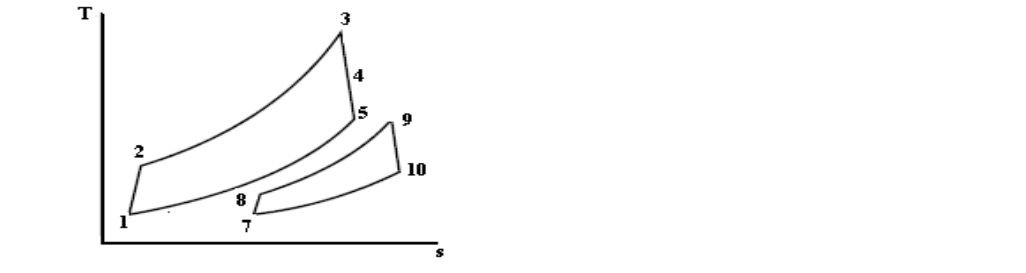
Figure 3. (T-s) diagram of the dual gas turbine combined cycle (1, 2, 3, 4, 5, 7, 8, 9 and 10 are the inlet and outlet of each component of GT-ABC and GT-sc-CO 2 BC in Figure 1b,c). Energy analysis is conducted for the three configurations (ASC, GT-ASC, and GT-sc- CO 2 BC). The energy balance equations applied for each component of the topping and bottoming cycles are listed in Table 6. Table 6. Model of energy